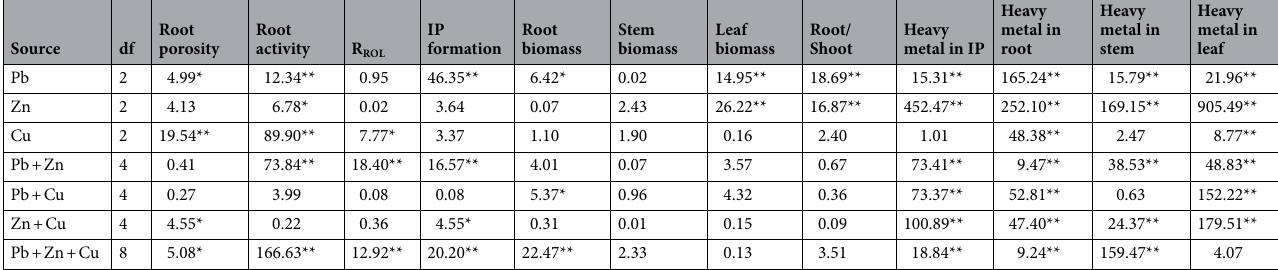
Table 3. Three-way analysis of variance of effects Pb, Zn, Cu, and their interaction on biochemical parameters in Kandelia obovata. Heavy metals in IP, root, stem, and leaf were the sum of Pb, Zn and Cu in each treatment.